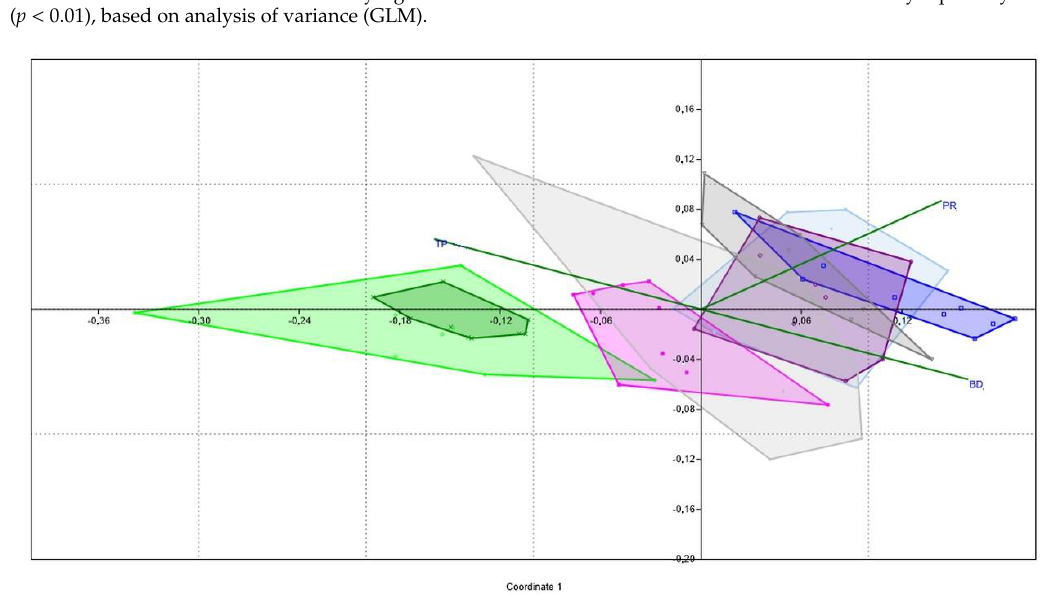
Figure 2. nMDS analysis for the soil situation 5 years after forest harvesting, related to the possible impact on the main variables (classes of light colors: slope < 20%; classes of dark colors: slope > 20%; green: control; violet: low intensity traffic; grey: medium intensity traffic; blue: high intensity traffic.